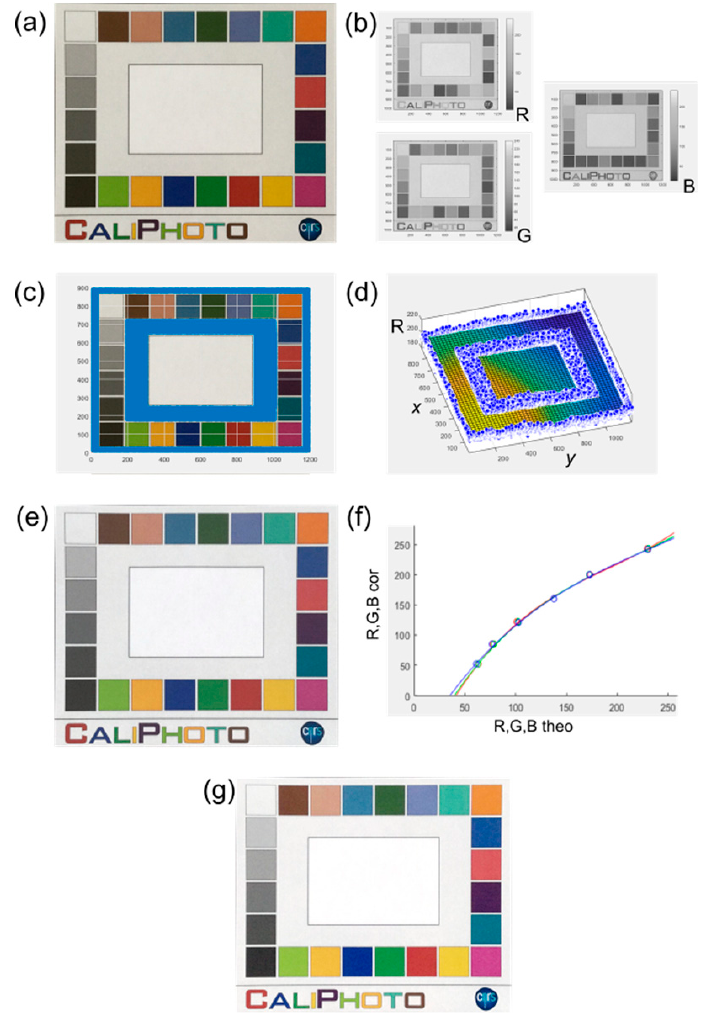
Figure A4. Image processing of the reference image of the colour plate. ( a ), image of the colour plate after rescaling and resizing using image processing software (see Figure A3). ( b ) Extraction of R, G and B channels. ( c ) Selection of the external and internal white rectangles (in blue when selected in the software). ( d ) Plane fit of the white rectangles in the R channel. ( e ) Corrected image after plane fit removing. ( f ) Theoretical values of the greyscale rectangles versus of their average values in e and polynomial regression. ( g ) Final reference image of the colour